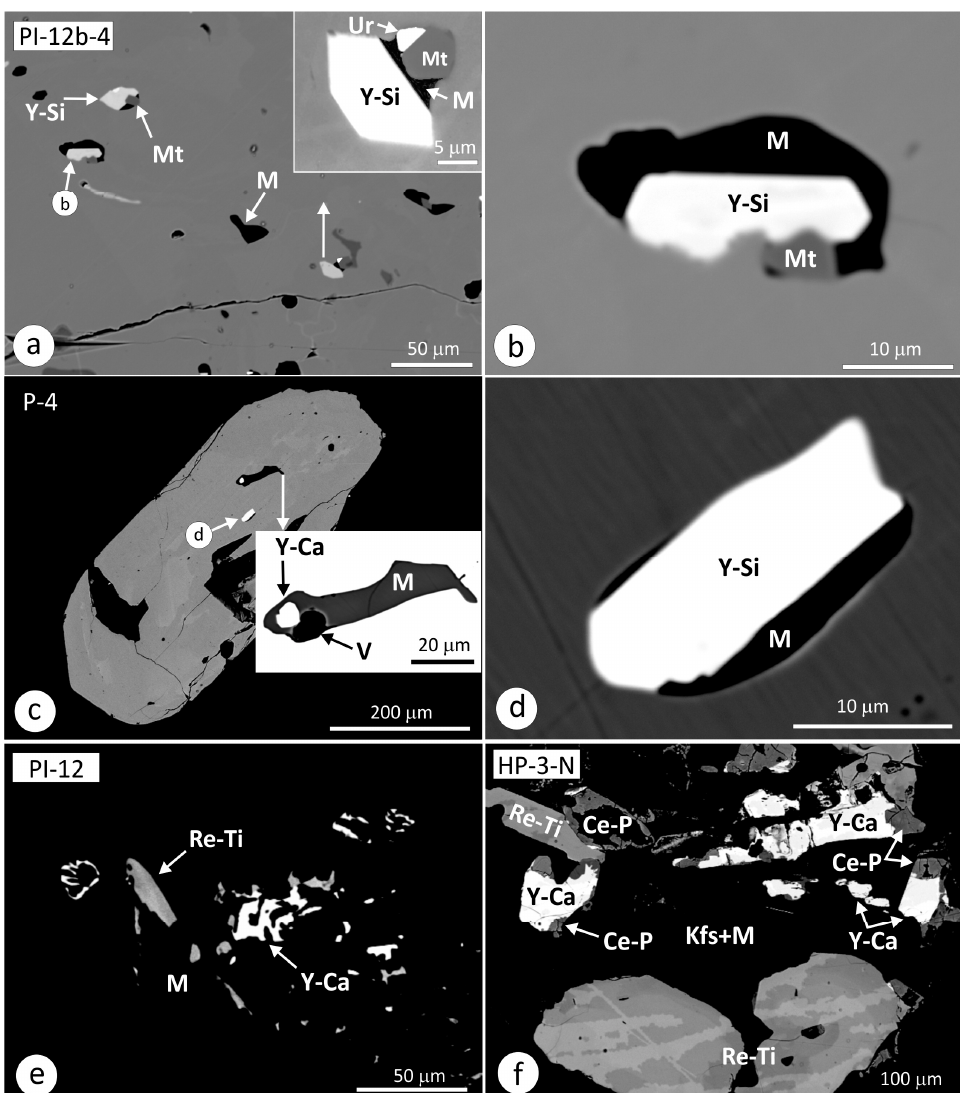
Figure 3. Back-scattered electron (BSE) images of yttrium silicates and associated minerals in sye- nite xenoliths and volcanic tuff ejected in the Pinciná maar. ( a ) Part of a large zircon crystal, 1 mm in size, in syenite xenolith showing numerous inclusions of silicate glass (M) and crystal aggre- gates composed of yttrium silicate (Y-Si), magnetite (Mt), and uranothorianite (Ur). Inset shows close-up of one of the crystal–glass aggregates. ( b ) Magnified view of the inclusion from the previous image, showing euhedral yttrium silicate, magnetite, and silicate glass. ( c , d ) Zir0con isolated from volcanic tuff with two bright yttrium silicate crystals embedded in silicate glass (M). The close-up documents an elongated silicate glass inclusion with vapour bubble (V) and bright Ca-Y silicate (Y-Ca). Another yttrium silicate (Y-Si) embedded in silicate melt is documented in ( d ). ( e , f ) BSE images documenting the close spatial relationship of REE-Ti silicate (Re-Ti), Y-Ca silicate (Y-Ca), and Ca-Ce phosphate (Ca-Ce) in syenite xenolith HP-3. Dark matrix is composed of potassium feldspar (Kfs) and silicate glass